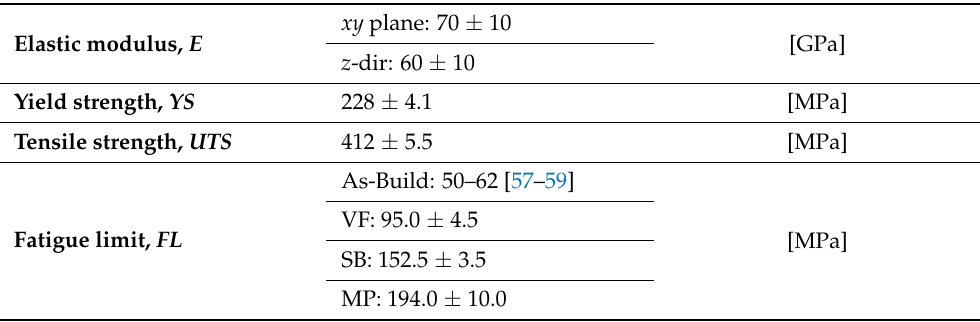
Figure 4. Fatigue curves based on Basquin fitting of the LPBF processed AlSi10Mg alloy [54,55]. Table 3. Main structural properties of AlSi10Mg [55].